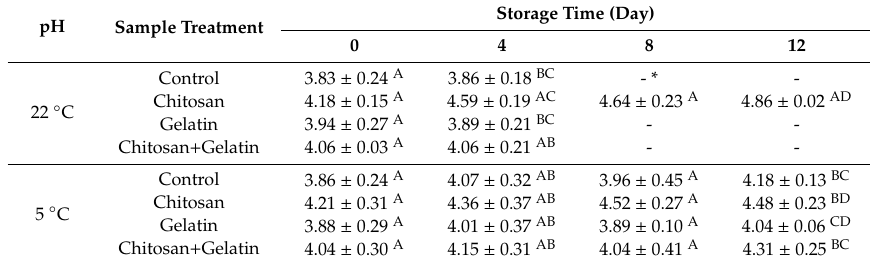
Table 3. pH changes of cut apple cubes coated with di ff erent coatings and stored at 5 ◦ C and 22 ◦ C for 12 days.